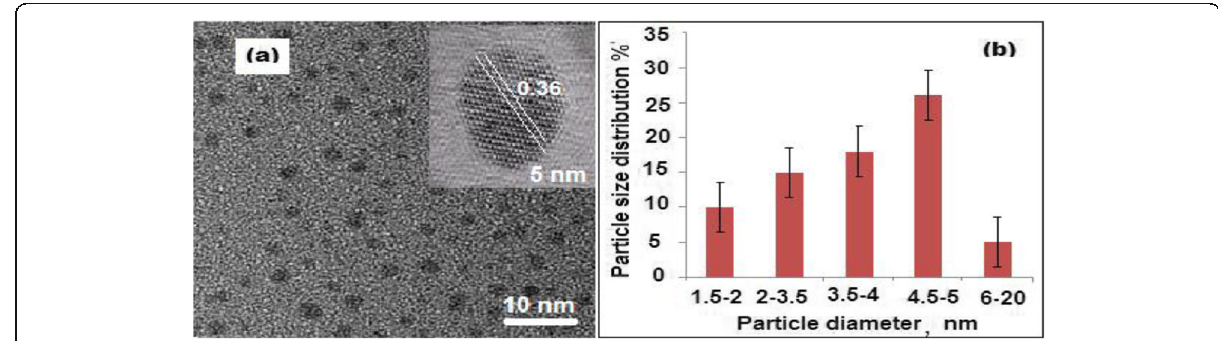
Fig. 1 a High-resolution transmission electron microscope (HRTEM) image of CQDs with diameter 5 nm and b size distribution graph of the CQDs based on the